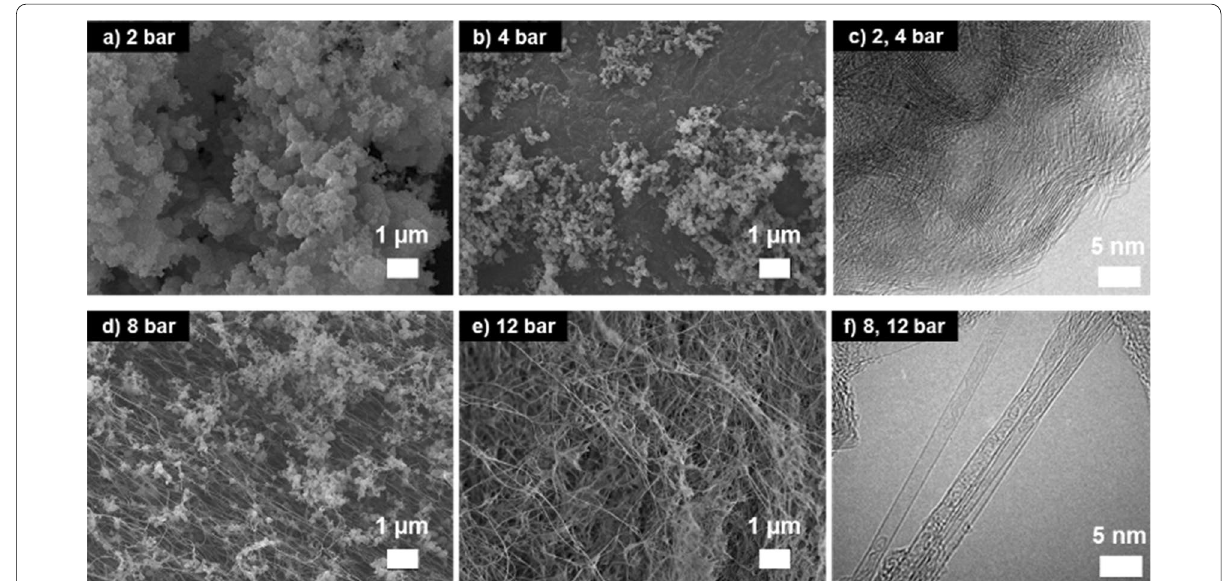
Fig. 4 Morphology of reaction products by SEM analysis at ( a ) 2 bar, ( b ) 4 bar, ( d ) 8 bar and ( e ) 12 bar and structure of reaction products by TEM analysis at c 2 bar (similar at 4 bar) and ( f ) 8 bar (similar at 12 bar) when the chamber is full of argon. The same results were obtained when the chamber is full of